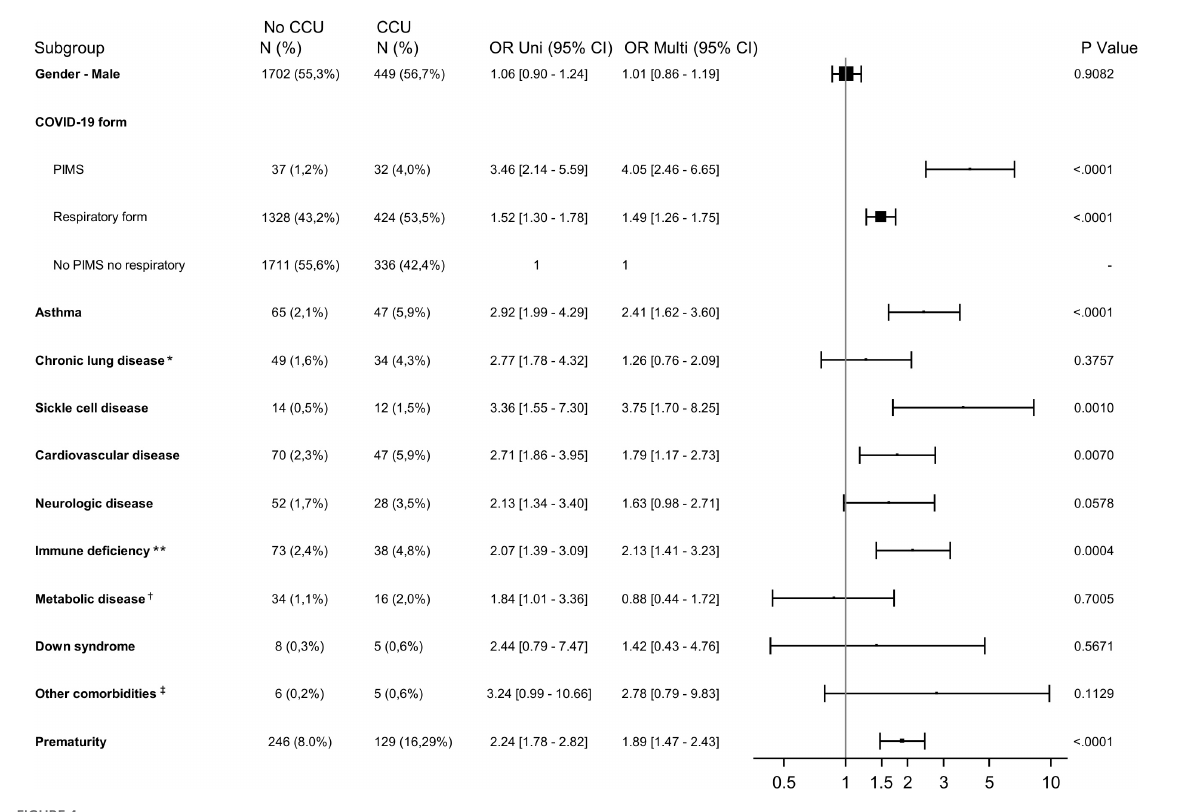
admissions. Unlike adults, Down syndrome and diabetes were not significantly associated (20,